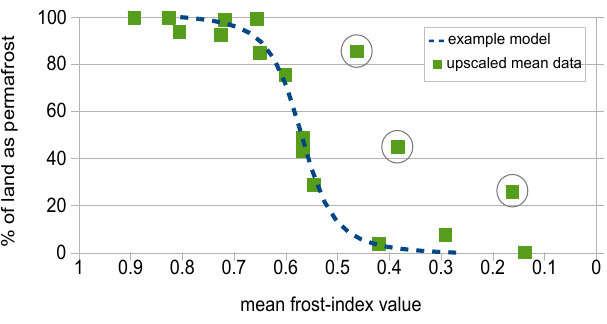
Figure 10. Frost-index-predicted permafrost fraction of land from Fig. 8 upscaled to the CLIMBER-2 grid and plotted against mean frost index for the same CLIMBER-2 grid cell. Circled points are where the total fraction of land vs. ocean in the grid cell is small (land is less than 25% of the grid cell) and ocean temperatures pull frost index lower (warmer). The dashed line is a representative re- lationship between frost index and permafrost land